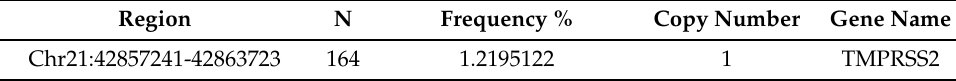
Table 2. Copy number variation (CNV) variants in the TMPRSS2 gene.